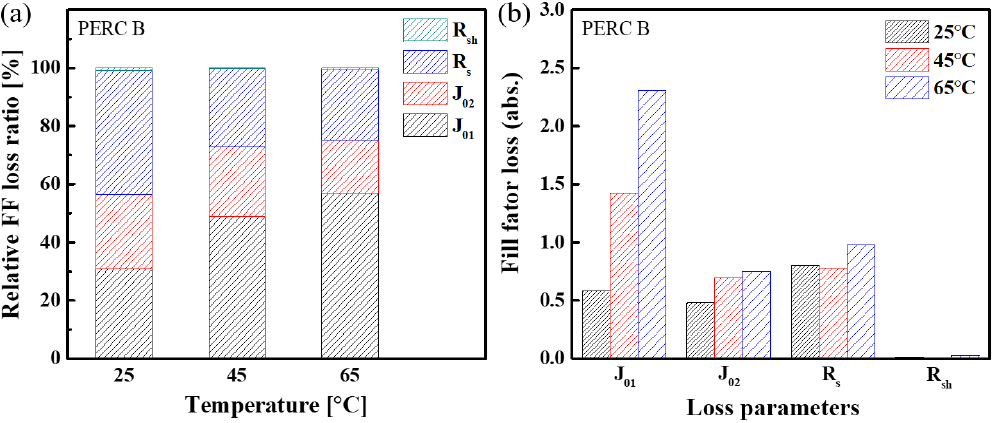
Figure 6. Fill factor loss analysis results of PERC B: ( a ) Normalized fill factor ratio; ( b ) Absolute fill factor loss.